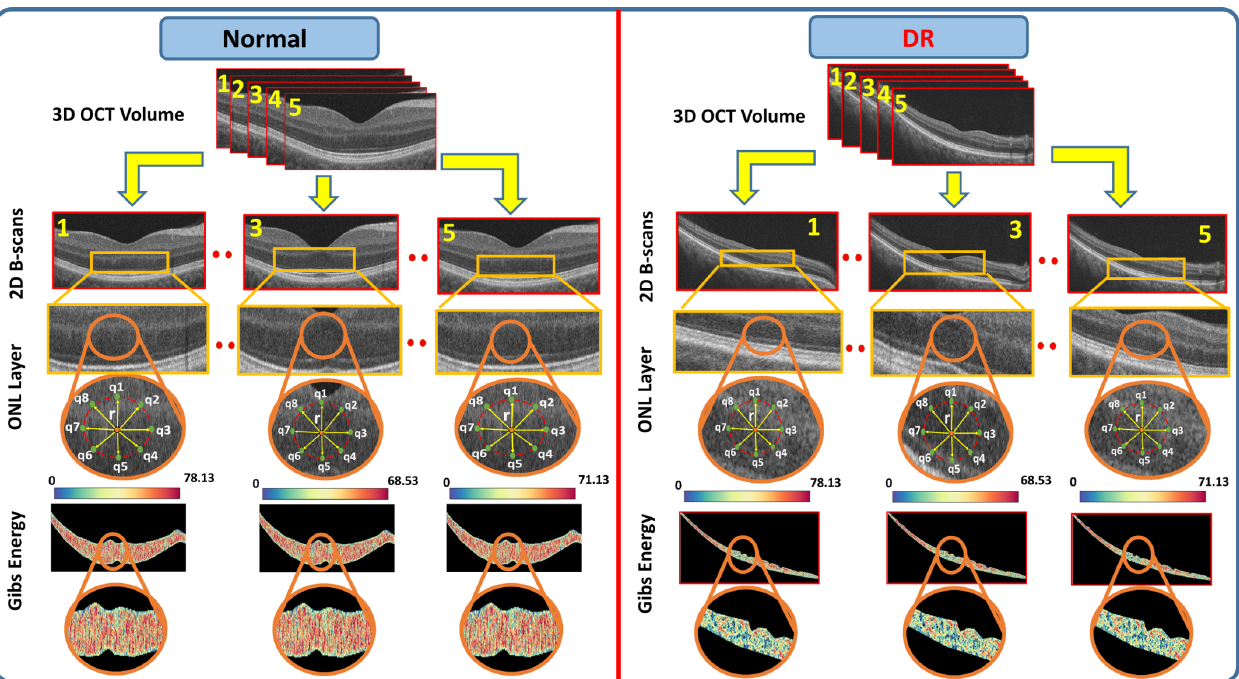
Figure 5. A color-coded illustration for the higher order reflectivity feature (Gibbs energy) extracted from segmented layer (ONL) for a healthy case (left panel) against a DR